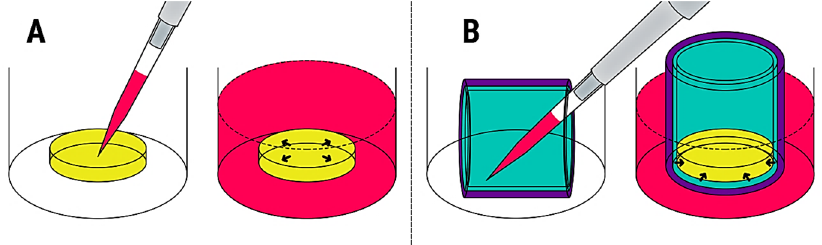
Figure 1. Comparison between static seeding and our proposed model. ( A ) Static seeding: a cell suspension is pipetted on top of the biomaterial, cells are incubated and allowed to attach to the scaffold. Fresh medium is then added. Finally, the cells migrate and proliferate within the scaffold. ( B ) In vitro model of wound healing: a porous membrane cell culture insert is coated with gelatin onto which human dermal fibroblasts (HDF) are later seeded. After allowing attachment, cells are covered with fresh medium and cultured for 1 h. The scaffold is placed at the bottom of the insert and fresh medium added. Finally, the HDF advance from the walls and the bottom of the insert to the biomaterial, thus mimicking the natural cell infiltration process of wound healing. Colour key: pink, cell culture medium (contains cells when in the pipette); purple, porous membrane cell culture insert; turquoise, gelatin coating and HDF; yellow, biomaterial. Arrows indicate the direction of cell infiltration and spreading.